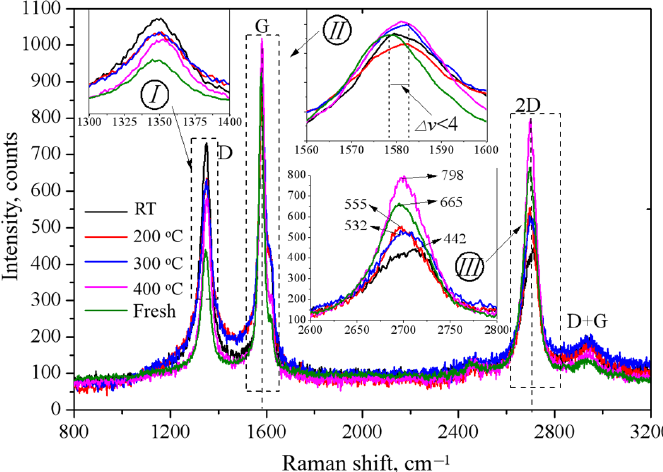
Figure 6. Raman spectra of the worn surface of PRG pin under different temperature.